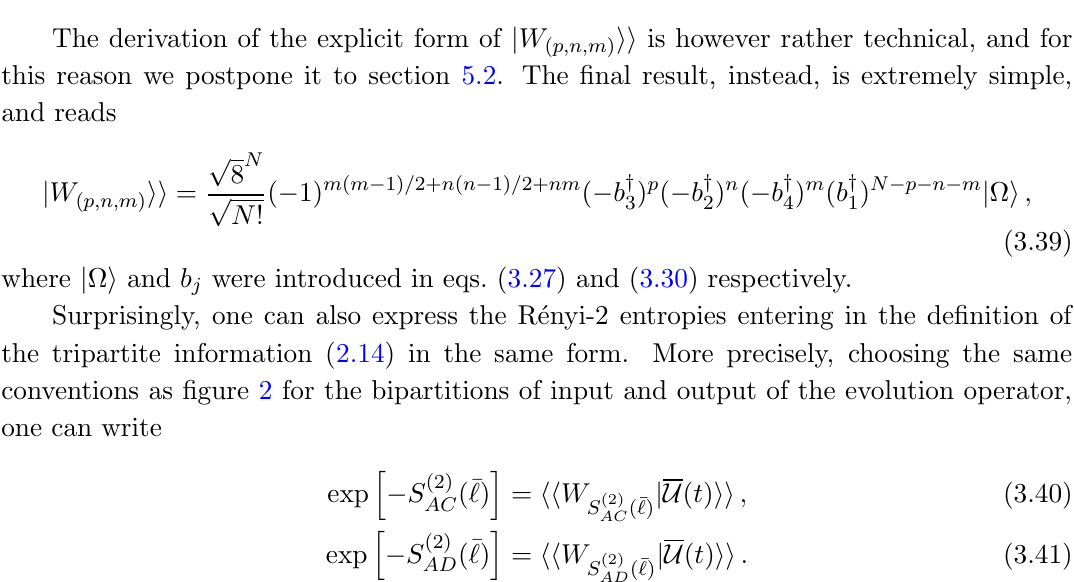
Figure 5 . OTOCs ( t ) and ( t ) of single-site Majorana fermions. Sub(cid:12)gures ( a ) and ( b ) F x;x F x;y show our numerical results for increasing system sizes for operators on the same site (from top to bottom) and on di(cid:11)erent sites (from left to right) respectively. In Sub(cid:12)gure ( a ) the black dashed line is the analytic prediction (4.2). Sub(cid:12)gure ( c ): the two di(cid:11)erent OTOCs are reported in the same plot, where the dynamics after the scrambling time is seen to